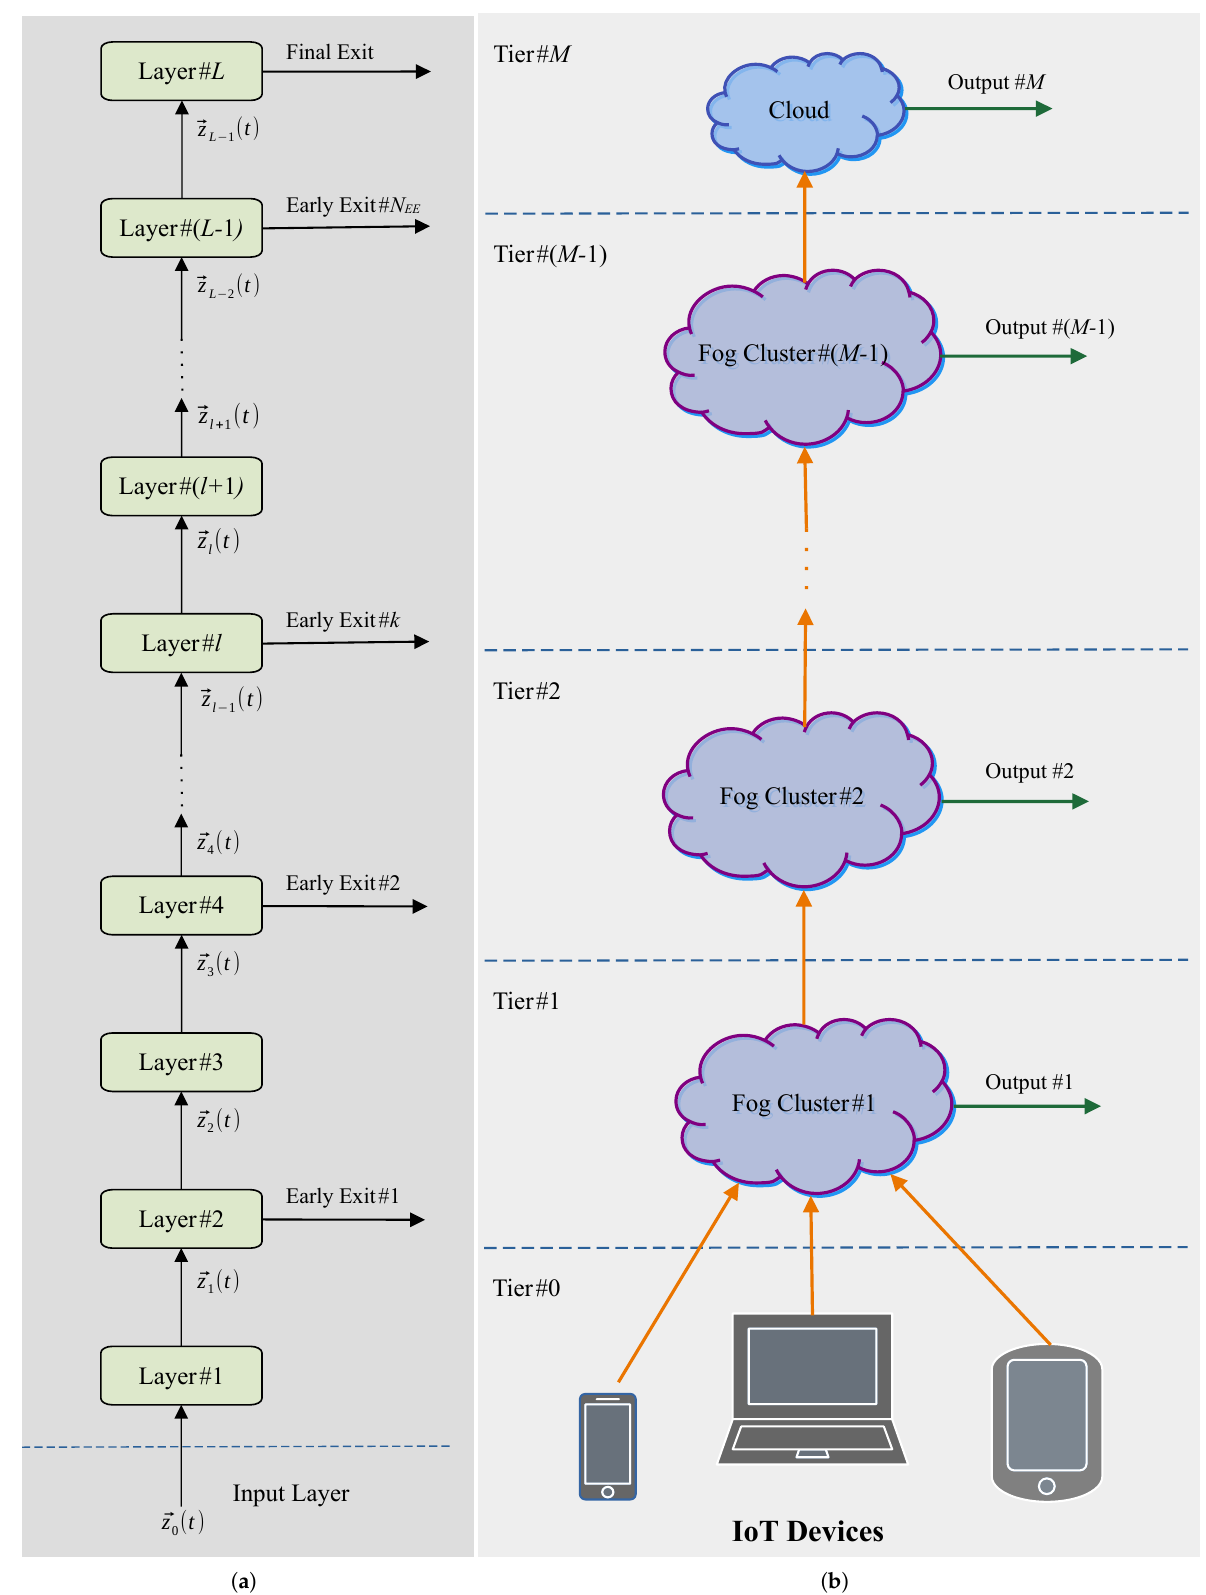
Figure 1. ( a ) Sketch of the stack topology of a Conditional Neural Network (CDNN) with L layers and N EE early exits; ( b ) sketch of a multi-tier networked Fog